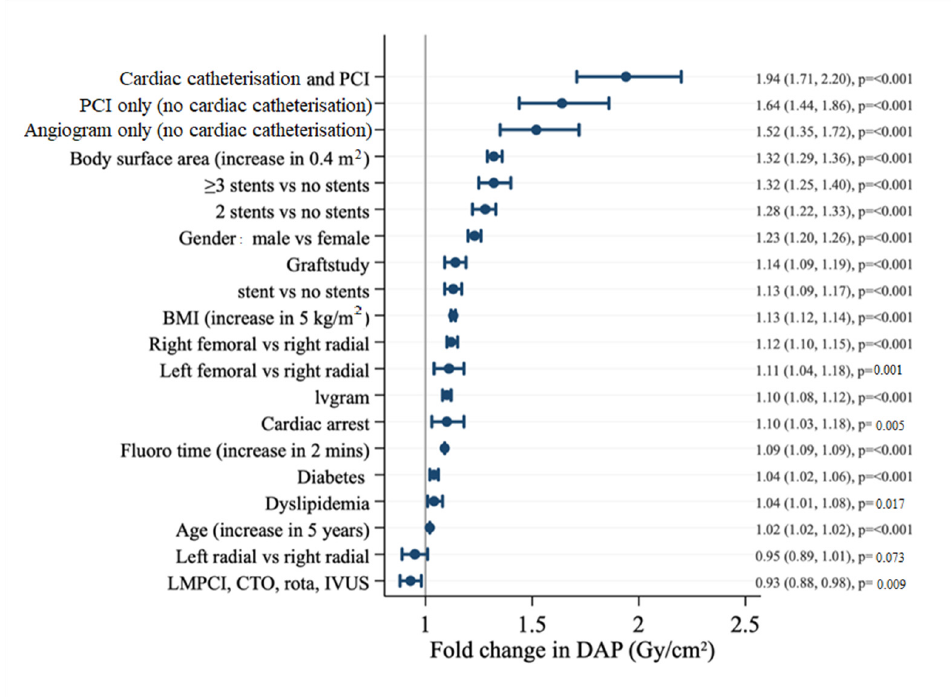
Figure 2. Multivariate analysis of whole cohort. BMI, body mass index; CTO, chronic total occlusion;